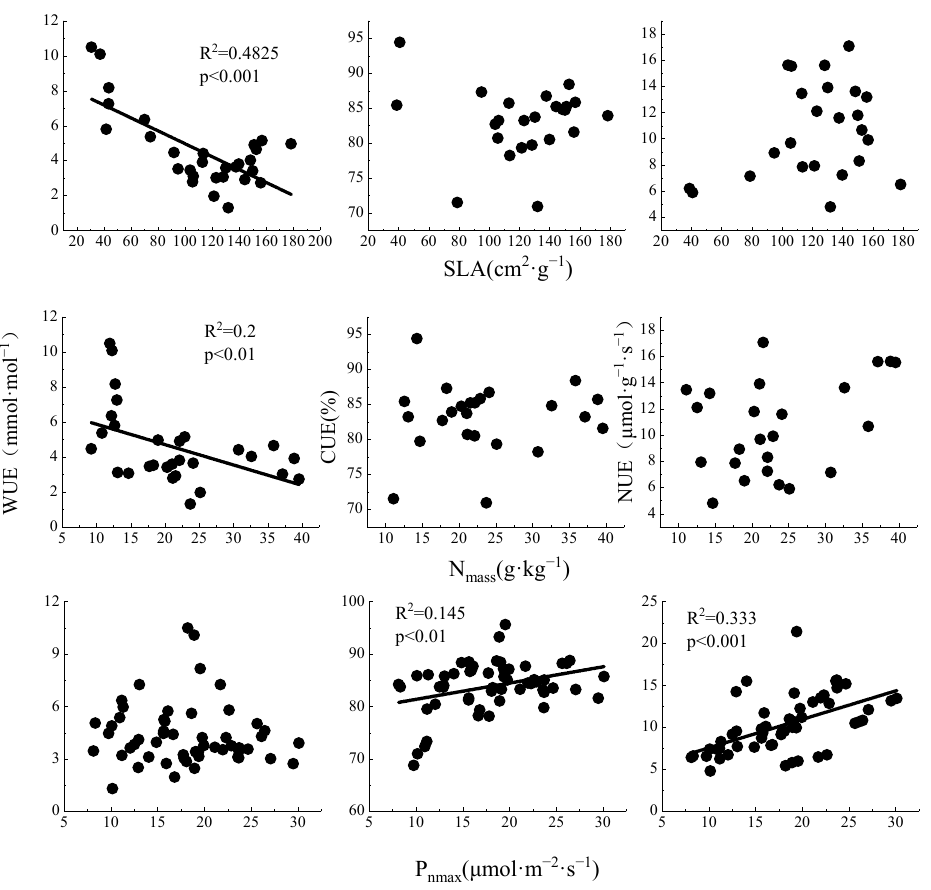
Figure 5. Relationship between specific leaf area (SLA), leaf nitrogen content ( N mass ), maximum net photosynthetic rate ( P nmax ), and resources utilization efficiencies.